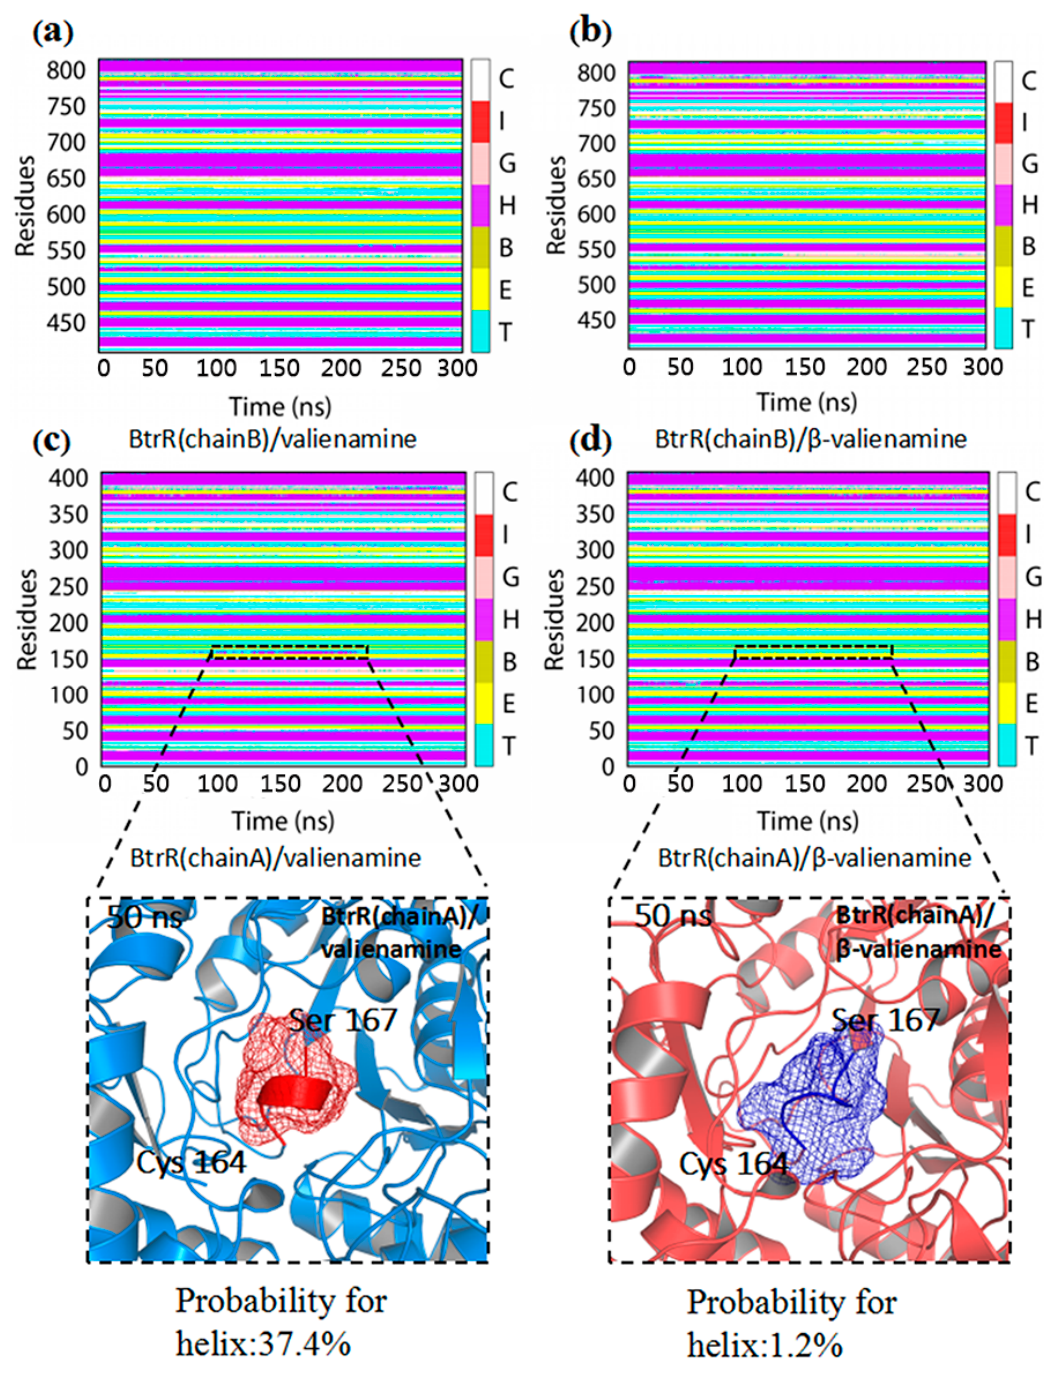
Figure 3. Dynamic changes of the secondary structure profile for BtrR/PLP/valienamine and BtrR/PLP/ β -valienamine throughout the simulation. ( a,c ) The the secondary structure profile for BtrR/PLP/valienamine. ( b,d ) The the secondary structure profile for BtrR/PLP/ β -valienamine. The colored bar represented different secondary structures as follows: coil (C), β -bugle (E), β -bridge (B), helix (G), α -helix (H), and π -helix (I).